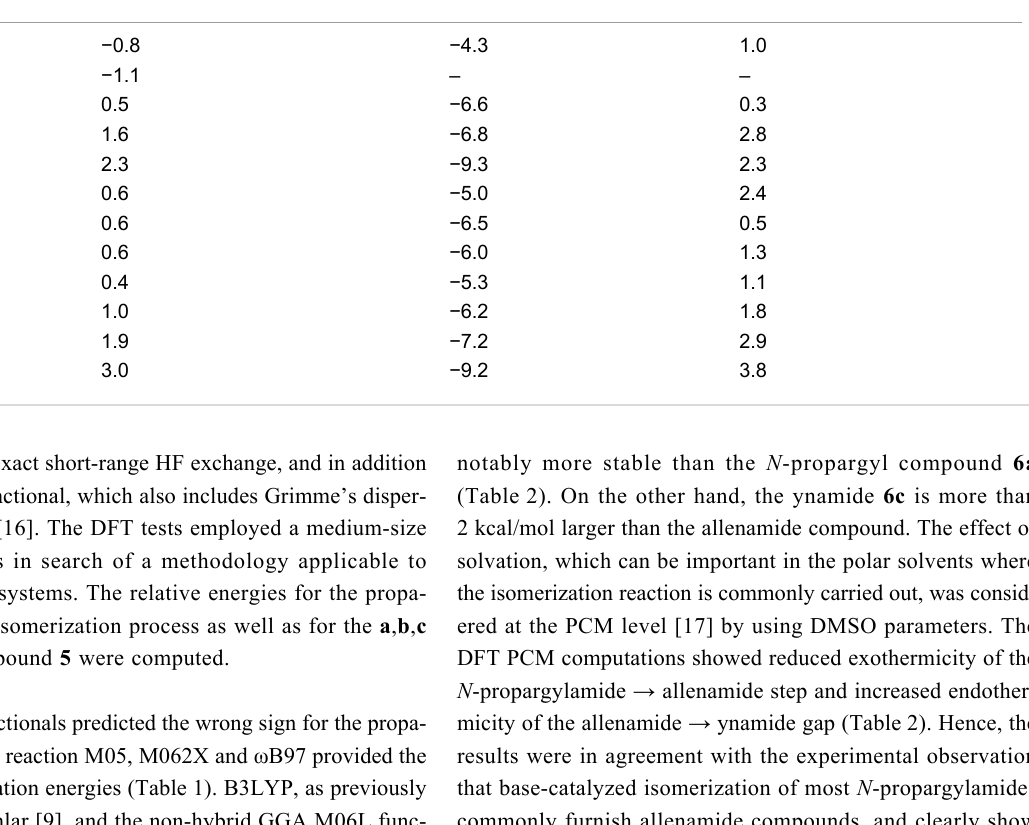
Table 1: Isomerization energies for the propadiene to propyne and the 5a , b , c system. Level